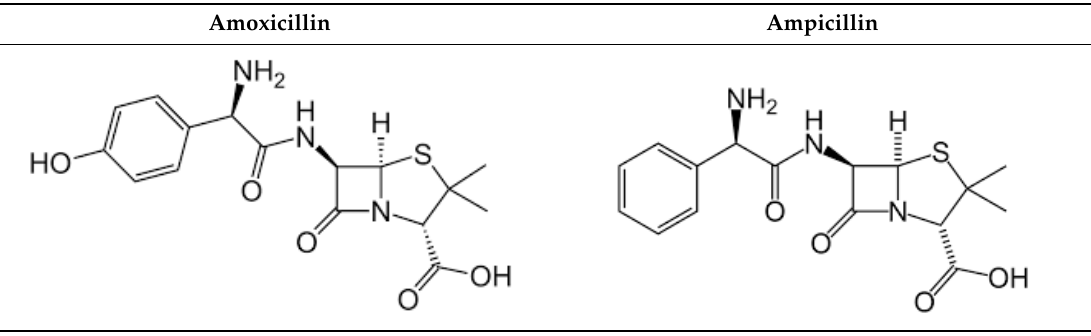
Table 1. Chemical structure of amoxicillin and ampicillin.